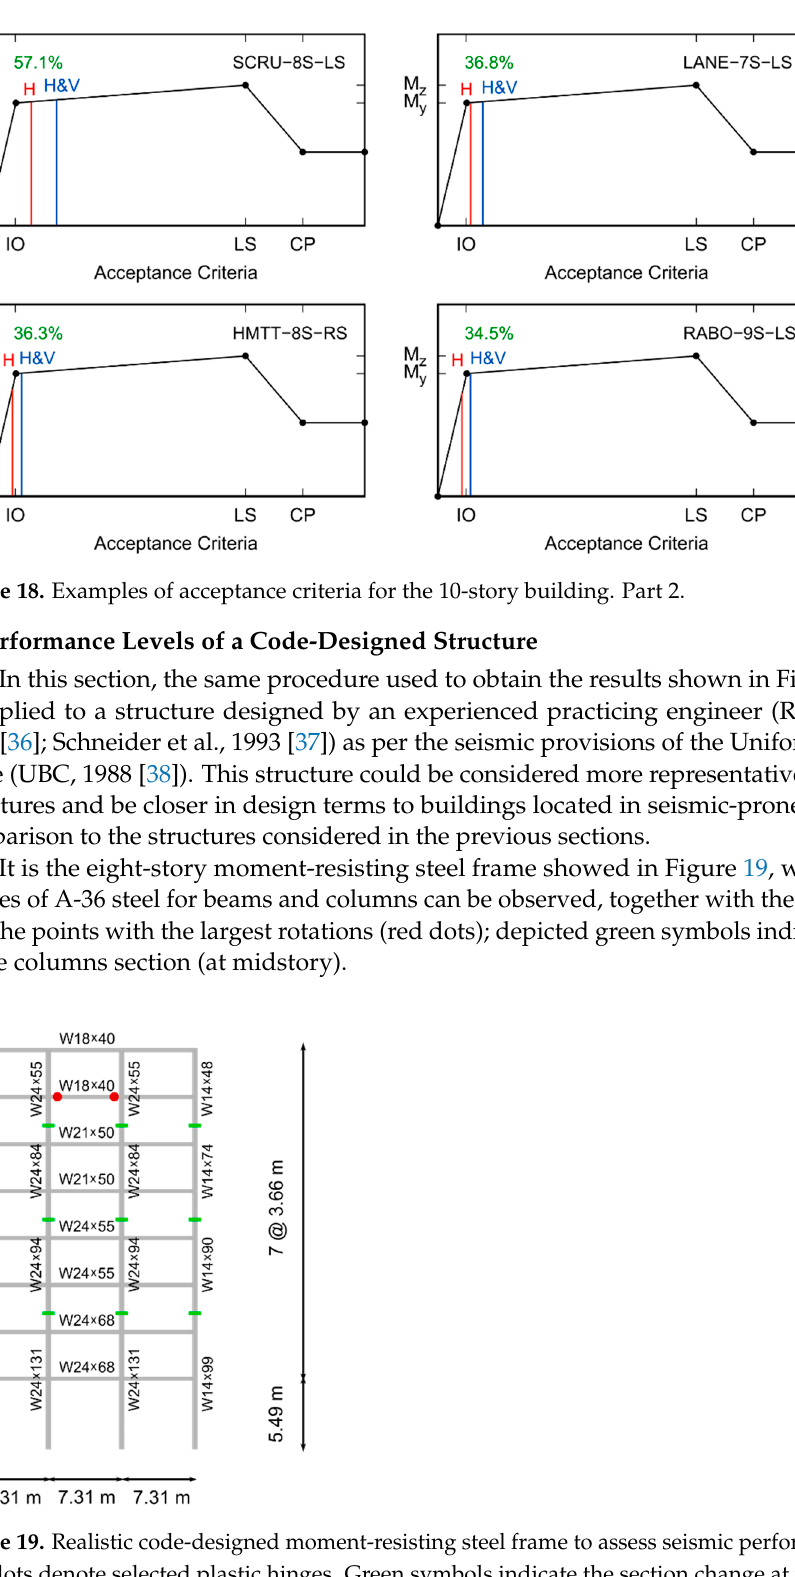
Figure 17. Examples of acceptance criteria for the 10-story building. Part 1.